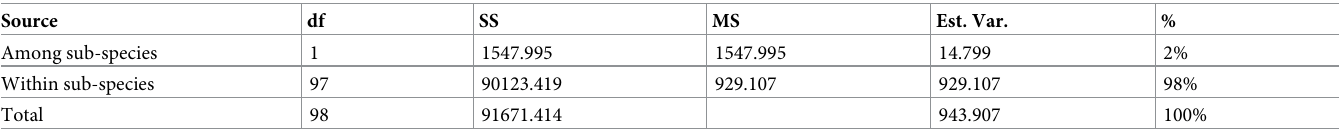
Table 7. Analysis of molecular variance based on two subspecies using 16,363 SNP markers in 99 groundnut genotypes. Source df SS MS Est. Var. % Among sub-species 1 Within sub-species 97 Total Note: df = degree of freedom, SS = sum of square, MS = mean square, Est. Var. = estimated